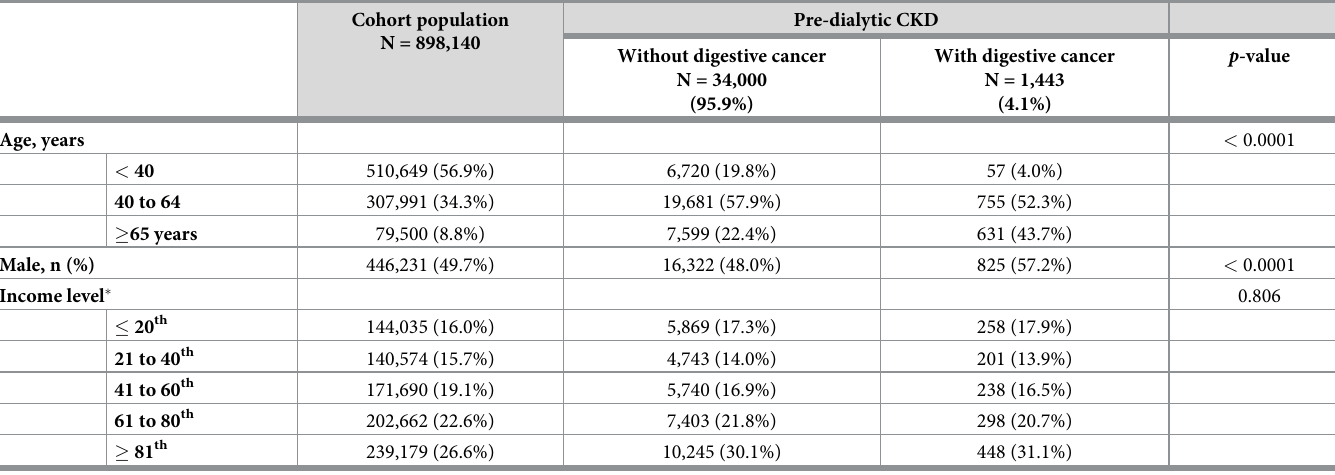
Table 1. Baseline characteristics in patients with pre-dialytic CKD.